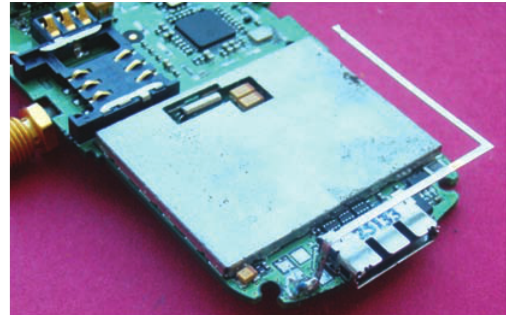
F 27: Conductive strip on a real handset PCB.